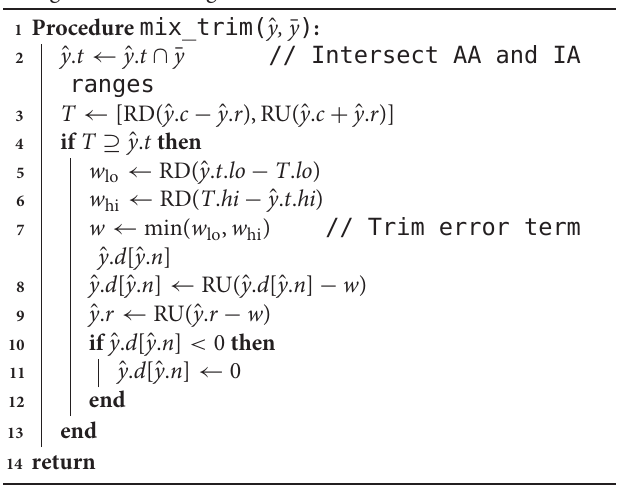
Algorithm 1: Algorithm for combining AA and